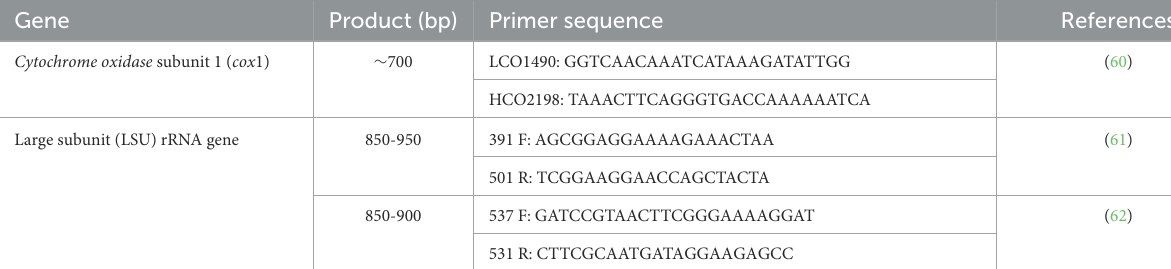
TABLE 2 Primers used for amplification and sequencing of Crenosoma specimens.